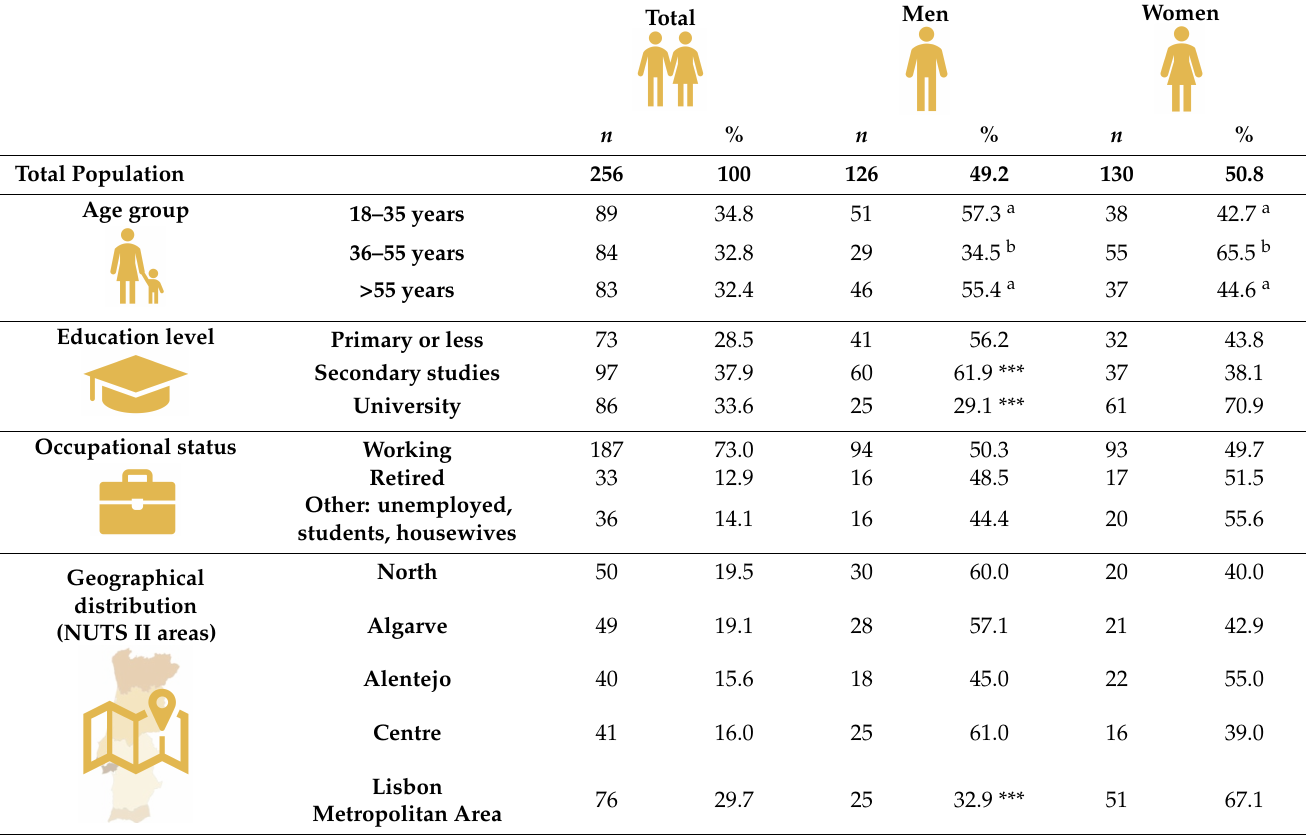
Table 1. Sociodemographic characteristics of the adult Portuguese sample population. Total Men Women